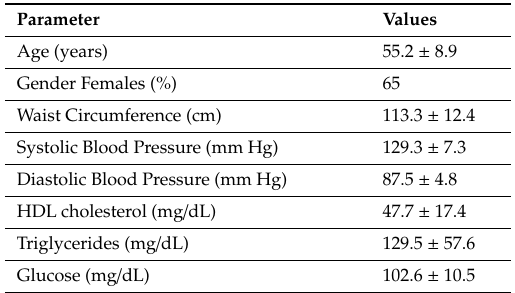
Values are expressed as mean ± Standard deviation for n = 23